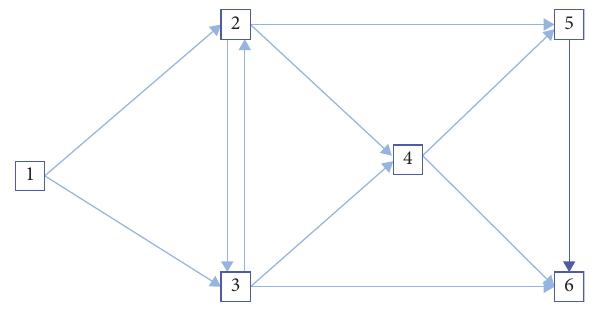
Figure 3: Simple urban road topology